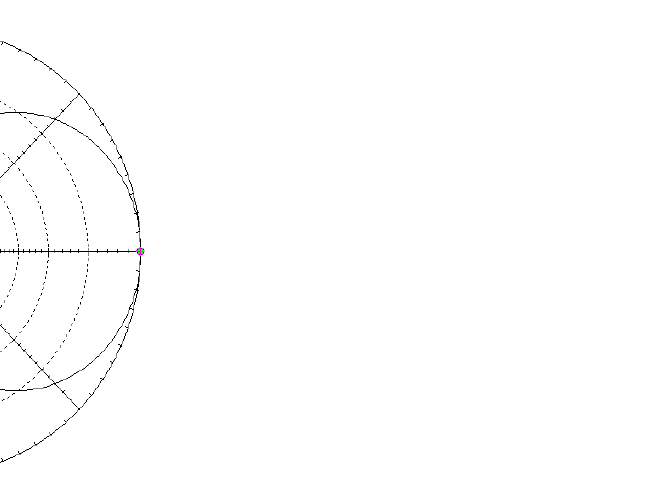
Figure 15. The free-space azimuthal response for the horizontal two-dipole phased-array antenna at 25 MHz and 30° elevation angle as simulated by EZNEC with gain = 7.23 dB, F/B = 19.79 dB, HPBW = 44.5°.